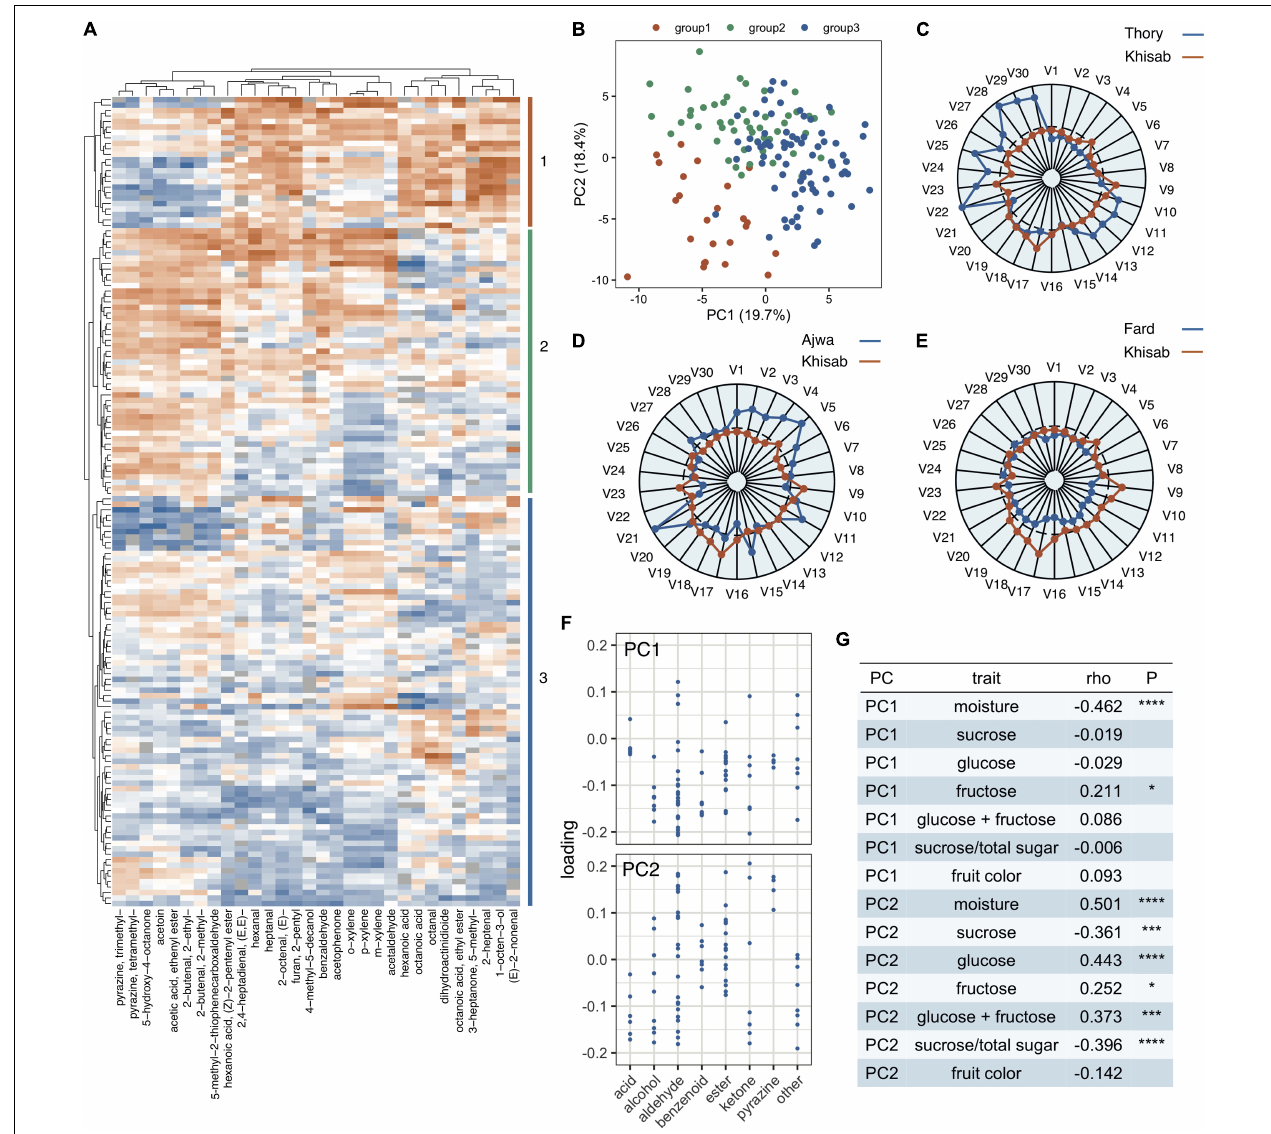
FIGURE 1 | Variation in volatile composition of fruits from 148 date palms ( Phoenix dactylifera ). (A) Hierarchical clustering of date palm samples (vertical axis) and volatiles (horizontal axis) based on 30 volatiles. The heatmap represents transformed volatile concentrations (orange = high, blue = low). (B) PCA of 148 date palms based on 80 volatiles. (C–E) Radar plots contrasting volatile composition in “Thory,” “Ajwa,” and “Fard” varieties representing groups 1,2 and 3, respectively, contrasted with the “Khisab” variety. Volatiles (V1-30) correspond to the 30 volatiles in (A) read from left to right. (F) Loadings for axes 1 and 2 of the PCA in (B) for volatiles categorized by their class as defined in Table 1 . (G) Table of Spearman’s Correlations of fruit traits and volatiles across date palm samples. Statistical significance is represented as * P < 0.05, *** P < 0.0005, and **** P < 0.00005, All analyses in (A–F) were conducted on log-transformed values scaled by Z-score transformation separately for each volatile. Outlier Z-score values were collapsed to –3 and 3 prior to clustering, heatmap, and radar plot